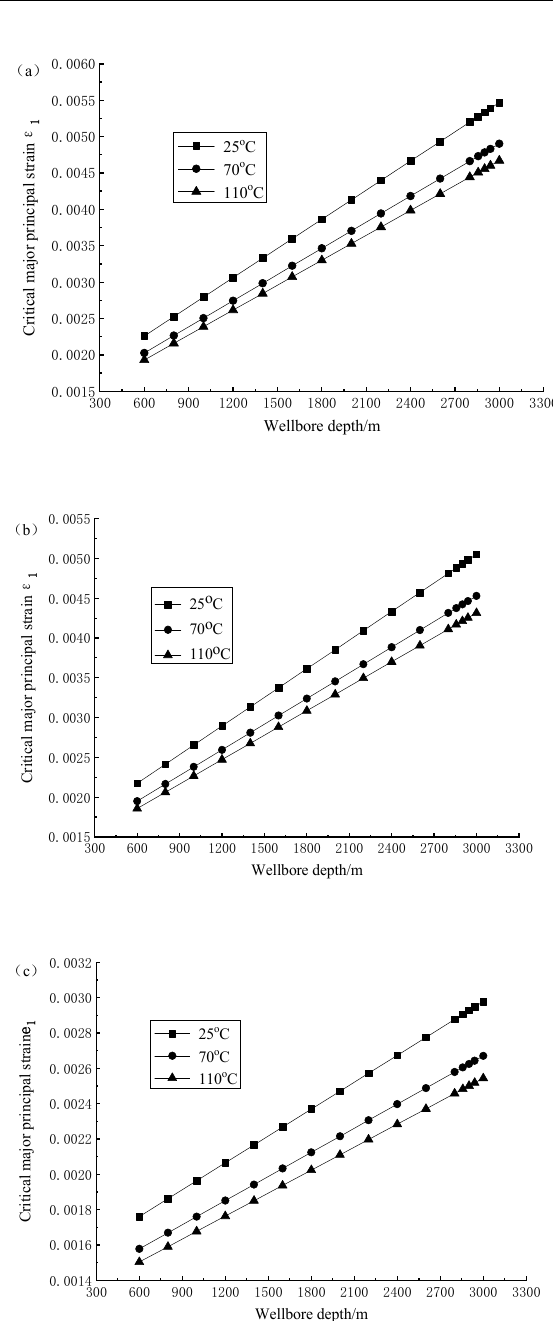
Figure 9. Critical collapse major principal strain and wellbore depth under the condition of different temperature values (different b values): ( a ) b = 1; ( b ) b = 0.5; ( c ) b = 0. Considering the temperature conditions, the critical major principal strain values were selected under the condition of different b values at three depths (600 m, 1800 m and 3000 m), as shown in Table 5. The data in Table 5 showed that the critical collapse major principal strain of the shaft wall increased, considering the effect of intermediate principal stress. However, the influence of intermediate principal stress on the critical collapse ma ‐ jor principal strain gradually decreased with the increase in b value. At the same time, the influence of different b values on the critical collapse major principal strain was basically the same under different temperatures. Taking the calculation results of b being zero as standard (using Mohr–Coulomb strength theory), the influence of intermediate principal